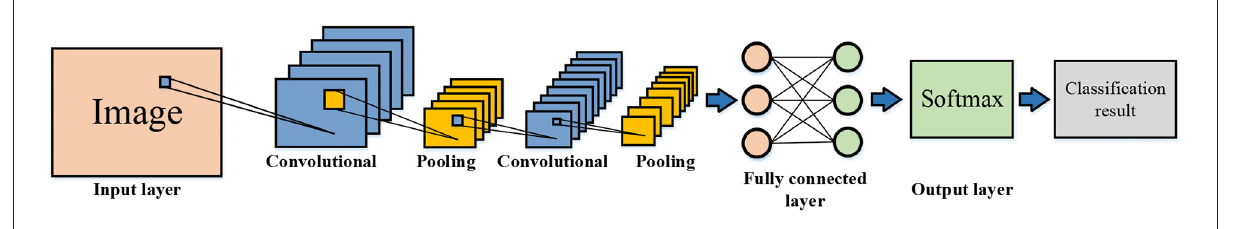
FIGURE2 Convolutional neural network structure